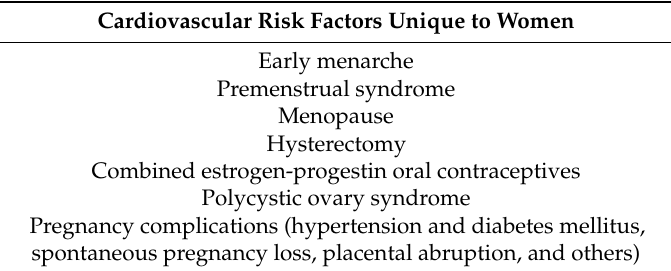
Table 1. Cardiovascular risk factors unique to women